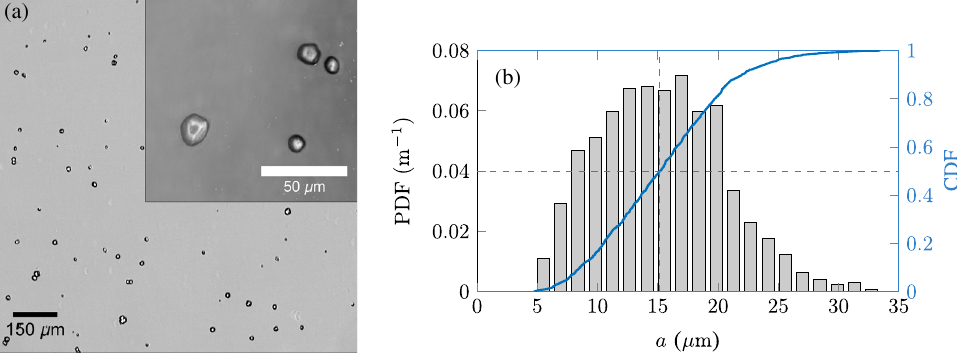
FIG. 8. Particle size distribution of cornstarch. (a) Bright field microscopy image of a dilute suspension of cornstarch. (b) Particle diameter distribution obtained from microscopy images (in gray) and cumulative distribution function (CDF) (in blue). Dotted lines indicate the mean particle diameter h a i ¼ 15 μ